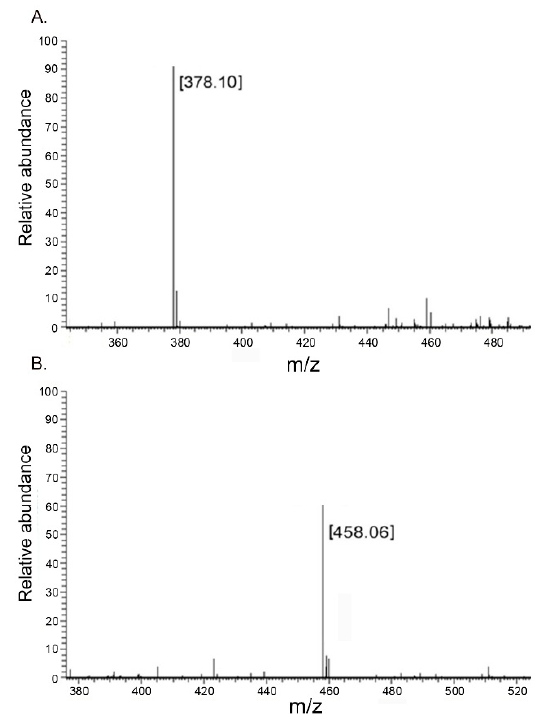
Figure 10. ESI-MS spectrum of purified degradation end-products of YsHyl8A: ( A ) The degradation result of YsHyl8A towards HA; ( B ) The degradation result of YsHyl8A towards CS.